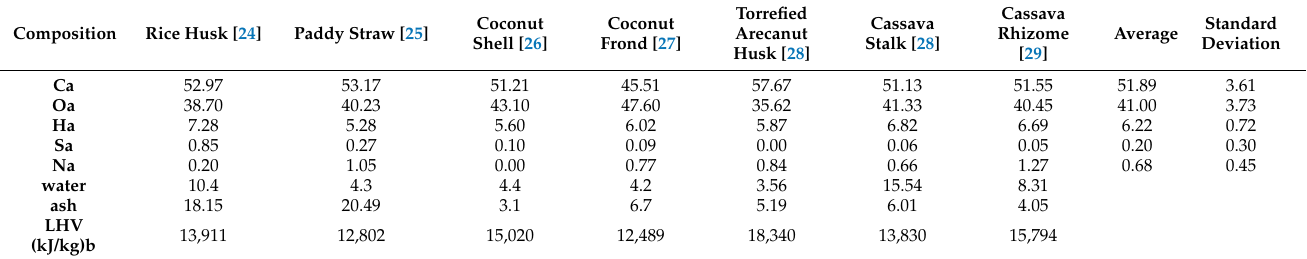
Table 1. Ultimate and proximate analysis of biomass resources [24–29].